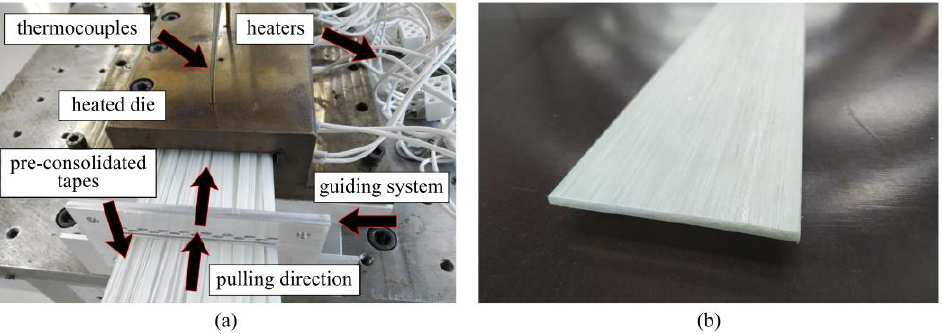
Figure 6. Pultrusion of thermoplastic flat GF/PP laminates based on inhouse-made PCTs: ( a ) in- house-made PCTs entering the heated die; ( b ) pultruded flat laminate. made PCTs entering the heated die; ( b ) pultruded flat